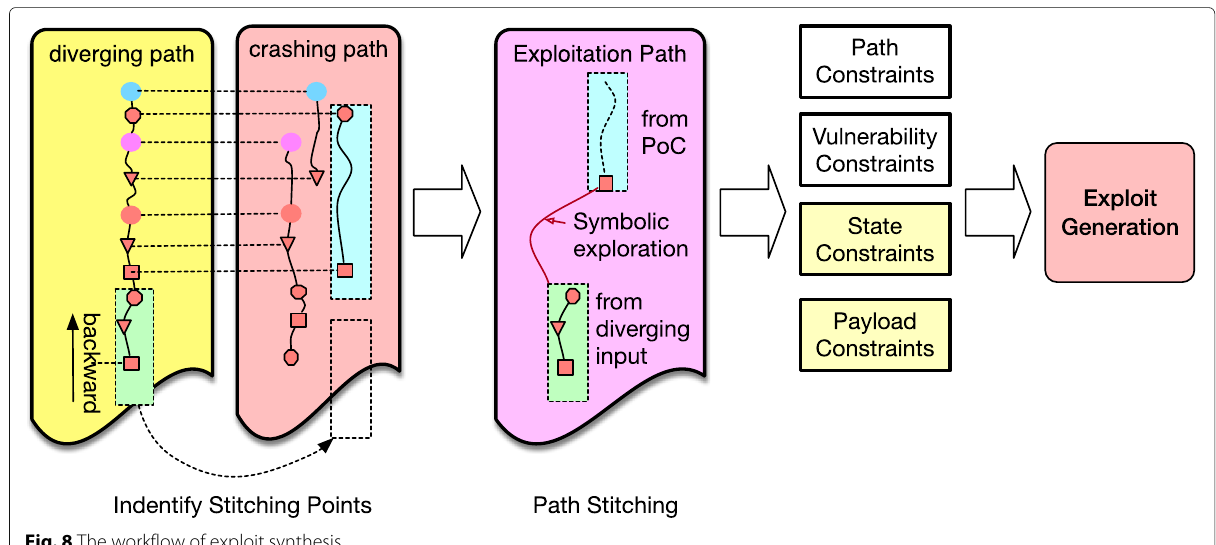
Fig. 8 The workflow of exploit synthesis